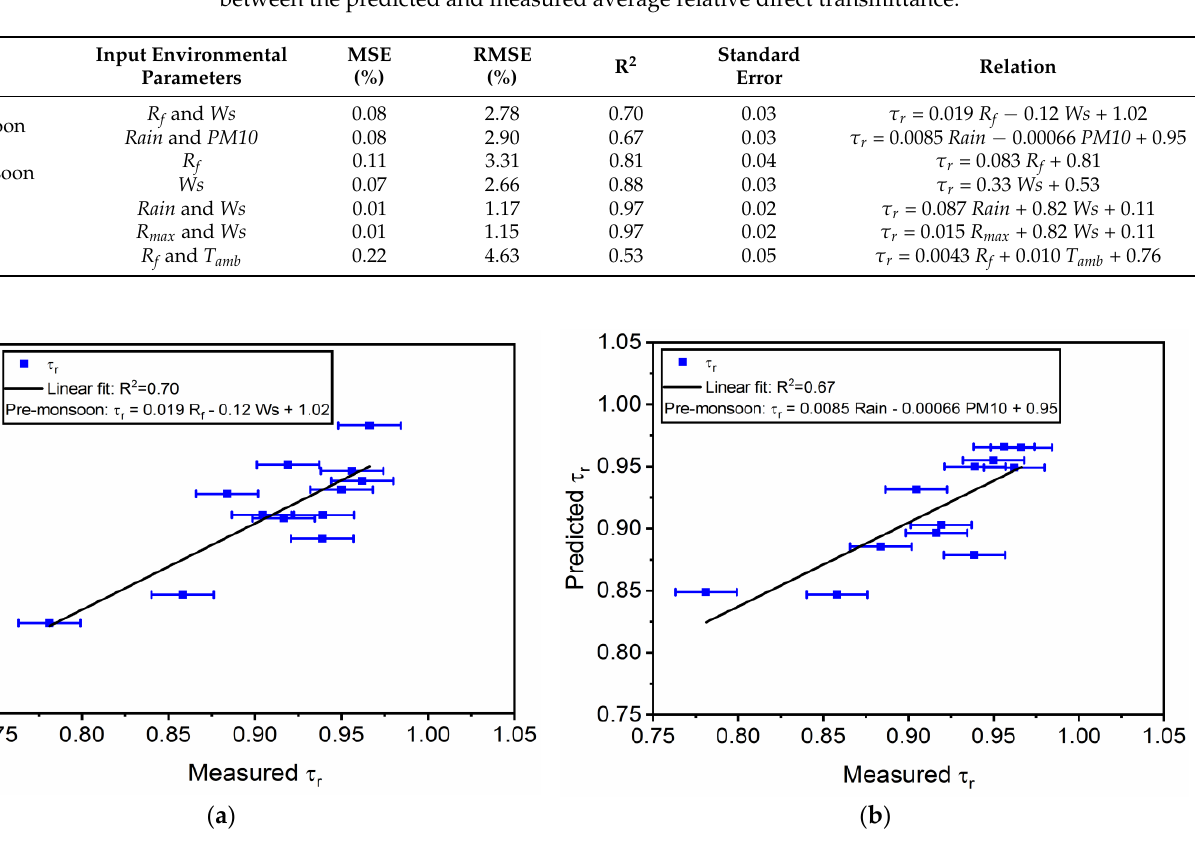
Figure 10. Regression plot of predicted transmittance and measured transmittance of weekly cleaned glass (G2) using the MLR model during pre-monsoon season for various environmental parameters: ( a ) R f and Ws and ( b ) Rain and PM10 . The uncertainty associated with the average relative direct transmittance of the weekly cleaned glass coupon during pre-monsoon is ±0.018.